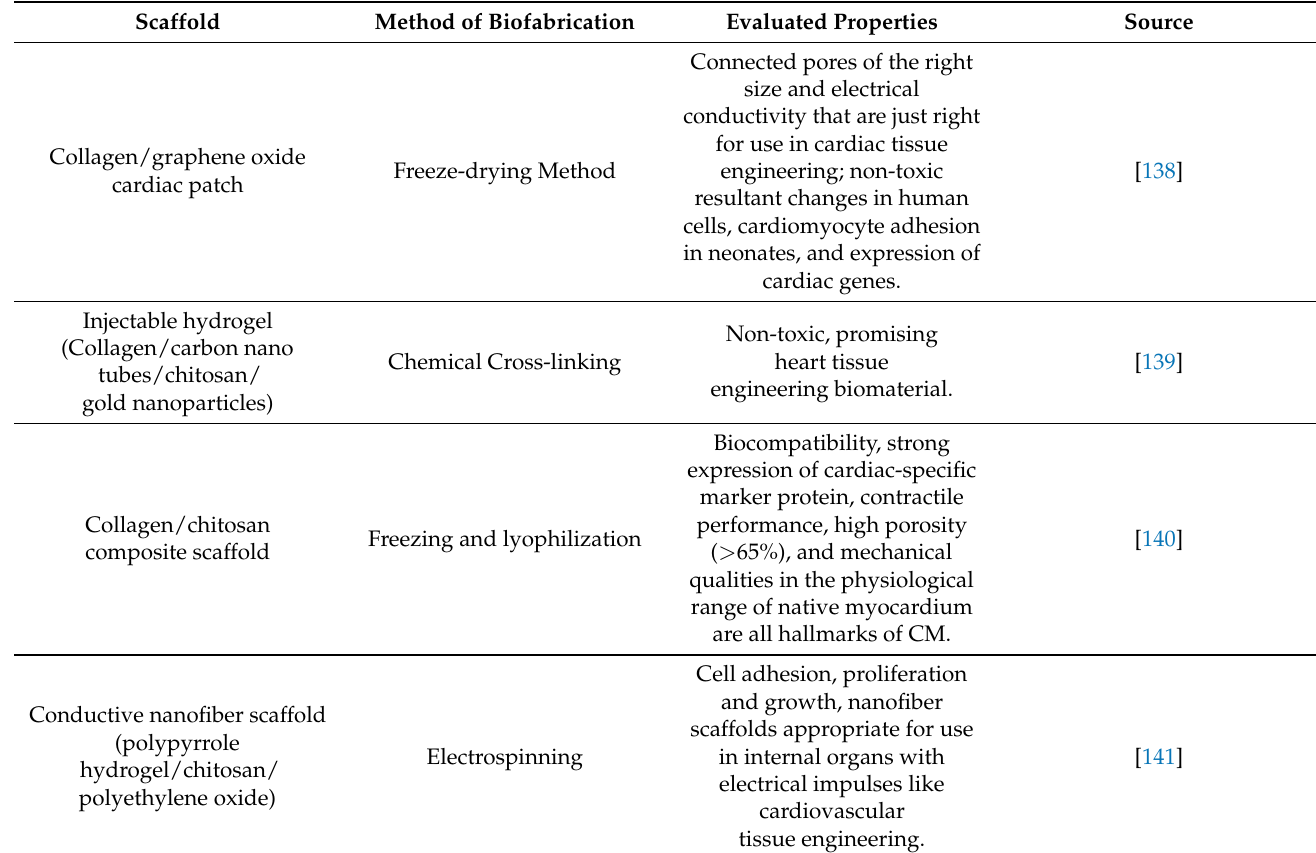
Table 1. Collagen scaffolds for heart tissue